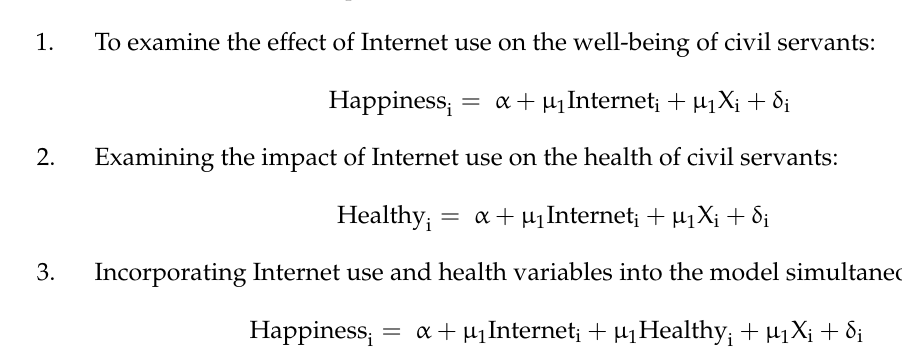
Figure 5. Mediation relationship.